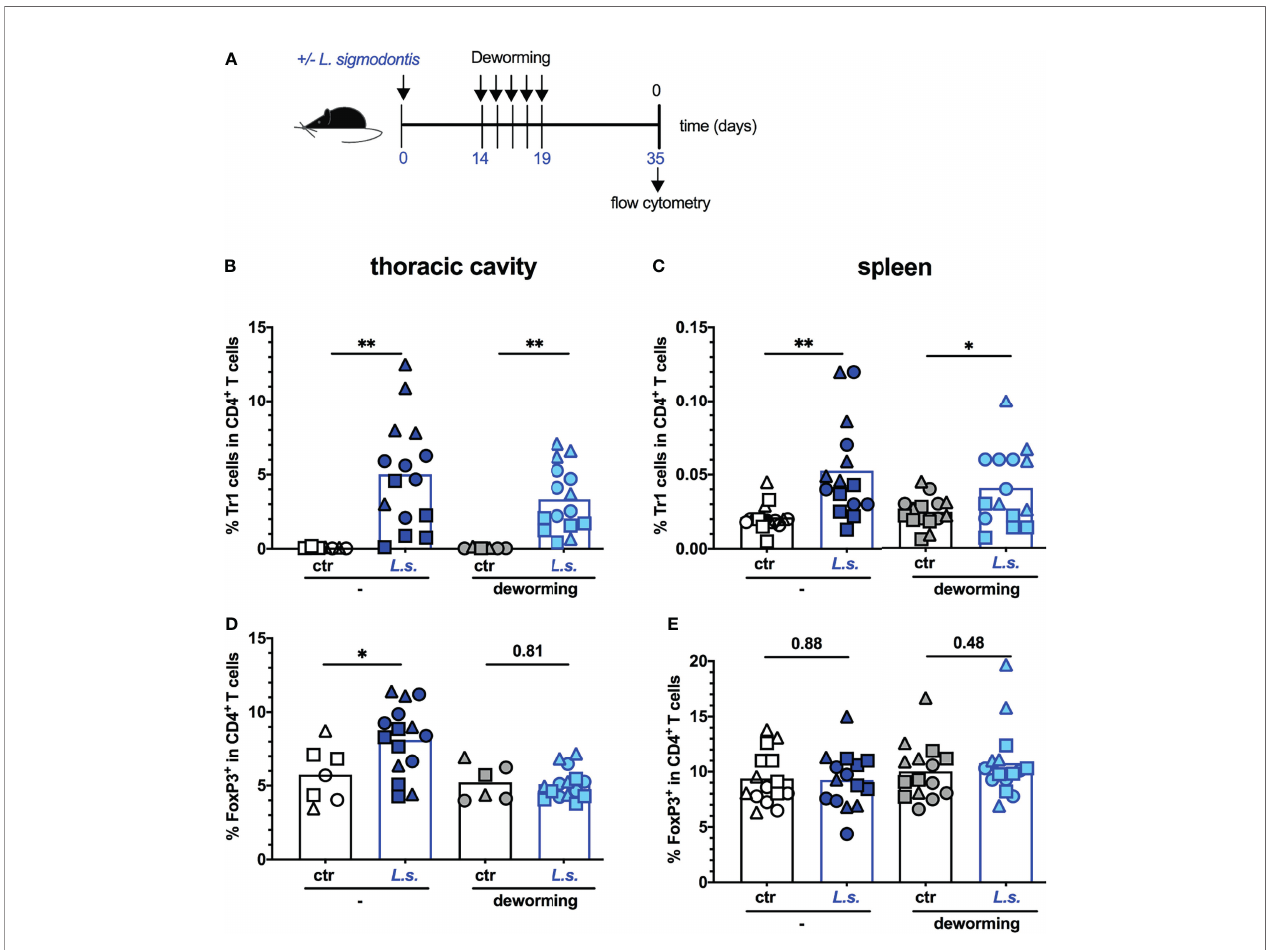
FIGURE 3 | Tr1 cells remain expanded 2 weeks after deworming. (A) Experimental design: C57BL/6 mice were left naive (white and grey symbols) or naturally infected with L. sigmodontis (dark and light blue symbols). Mice were dewormed by daily s.c. FBZ injection (grey and light blue symbols) for 5 consecutive days on day 14 p.i. until day 19 p.i. or were left untreated. Deworming ef fi cacy is shown in Supplementary Figure S1 . Mice were sacri fi ced at day 35 post L. sigmodontis infection. Tr1 cells in thoracic cavity (B) or spleen (C) were quanti fi ed as CD4 + Foxp3 - LAG-3 + CD49b + cells. Treg in thoracic cavity (D) or spleen (E) were quanti fi ed as CD4 + Foxp3 + cells. The gating strategy and exemplary dot plots are shown in Supplementary Figure S2 . All original dot plots are provided in the supplementary material. Data is presented as combined results from 2-3 independent experiments with n ≥ 3 per group and experiment. Each symbol represents an individual mouse, squares, circles and triangles represent independent experiments, the bars show the mean. Asterisks indicate statistically signi fi cant differences applying unpaired t test (* p ≤ 0.05, ** p ≤ 0.01, and numbers indicate p -values). ( L. sigmodontis , Litomosoides sigmodontis ; s.c., subcutaneous; FBZ, Flubendazole; p.i., post infection; Tr1, type 1 regulatory T cells; Treg, regulatory T cells; Foxp3, Forkhead-Box-Protein P3; CD, cluster of